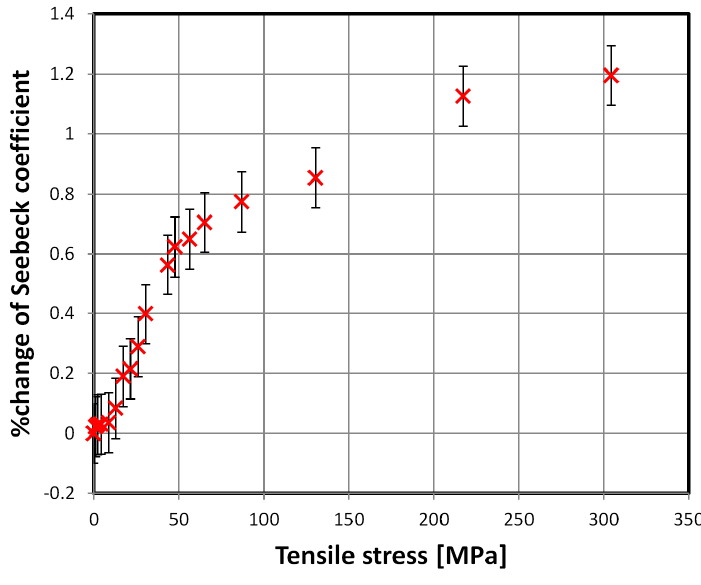
Figure 3. Relative change of the mean Seebeck coefficient due to tensile stresses, 2605CO alloy.